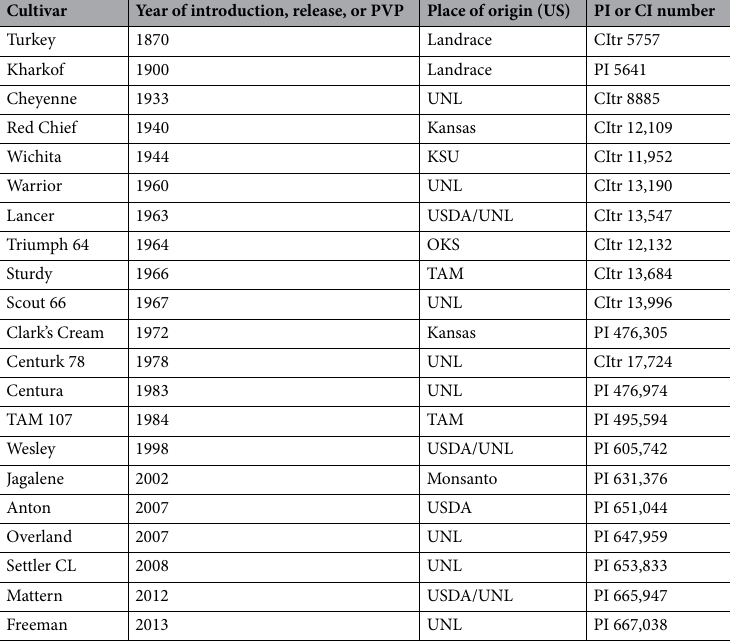
Table 1. Release year, origin, and plant introduction (PI) or cereal introduction (CI) number. For the wheat cultivars used in this study. PVP plant variety protection, USDA US Department of Agriculture,